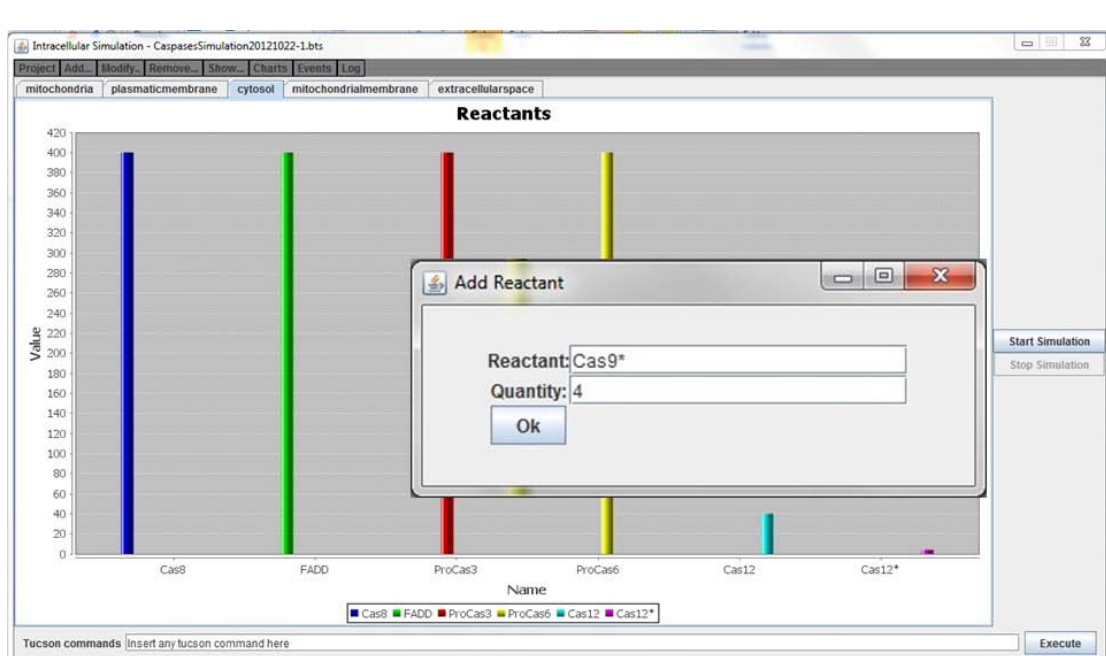
Figure 4: Introduction of reactants in the cytosol